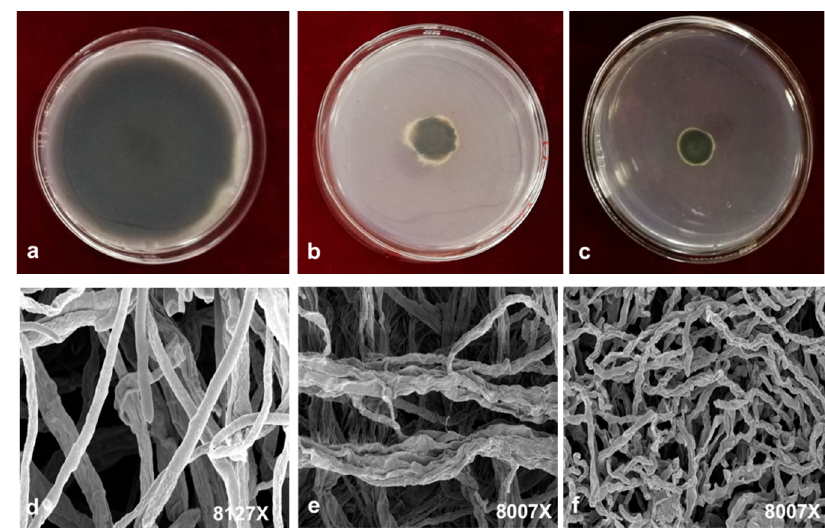
Figure 4. Observation of hyphae morphology of A. alternata by electron microphotography. The colony of A. alternata on PDA plates is shown in ( a – c ): ( a ). Control PDA plate; ( b ). PDA plate containing magnolol (0.1 mg / mL); ( c ). PDA plate containing honokiol (0.1 mg / mL). Hyphae morphology of A. alternata on the PDA plate is shown in ( d – f ): ( d ). Control PDA plate; ( e ). PDA plate containing the magnolol (0.1 mg / mL); ( f ). PDA plate containing honokiol (0.1mg / mL).